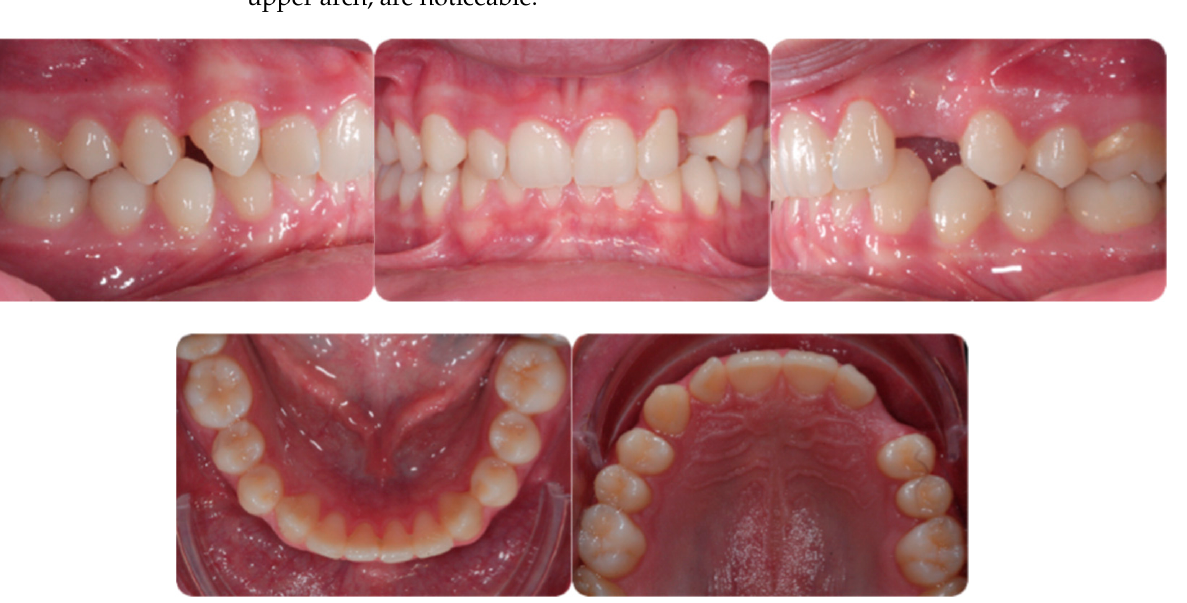
Figure 1. Pre-treatment records of the first patient. Figure 2 panoramic and CBCT showing the moderate palatal 2.3 impaction. Lateral X-rays confirming a Class I skeletal and dental malocclusion with deep bite.